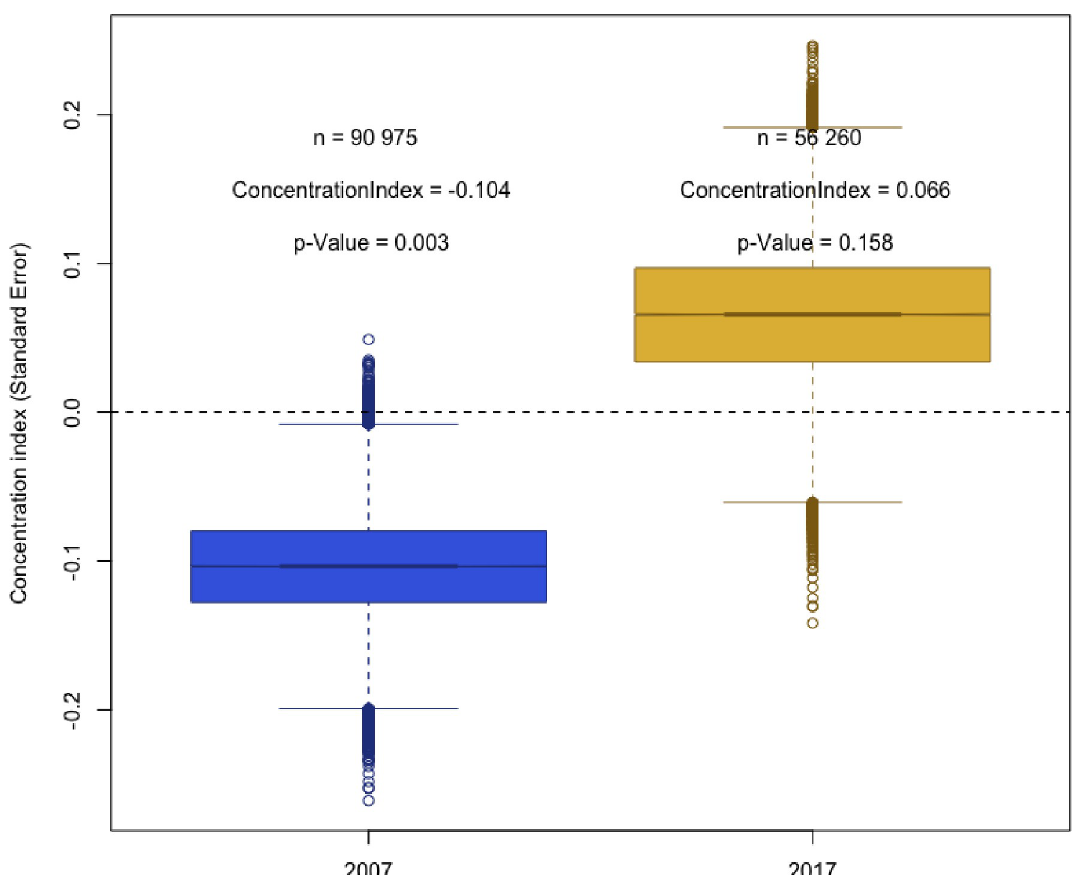
Fig 5. Illness concentration index for 2007 and 2017 Vie ˙ˆt Nam tuberculosis prevalence surveys. Sampling weights were applied. A negative concentration index means that the health outcome (tuberculosis illness) is concentrated in those who are poor, while a positive index value means that the disease is concentrated in those who are wealthier. The concentration index is an expression of the area between the concentration curve (Fig 4) AU : InthelegendtoFig 5 : IchangedTheconcentrationindex ð Fig 4 Þ isanexpressionoftheareabetweentheconcentrationcurve ð Fig 3 Þ toTheconcentrationindexisanexpressionoftheareabetweentheconcentrationcurve ð Fig 4 Þ : Ifthiseditisnotcorrect ; pleaseeditasnecessary : and the line of perfect equality. In the figure, the bars represent the mean, with the whiskers representing the distribution of data around the mean. The outlying data points are shown as circles above and below the whiskers.